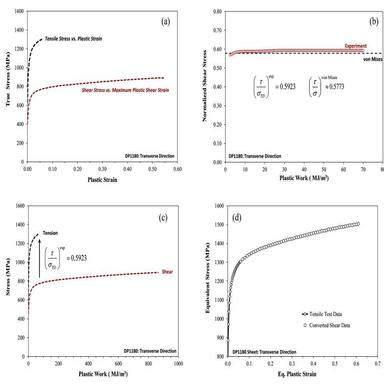
(a–d). Procedure for the characterization of the constitutive response using tensile and shear tests for DP1180 in the transverse direction. Shear anisotropy due to rotation of the material axes is neglected and the shear ratio assumed constant for plastic work levels higher than the tensile test after diffuse necking.